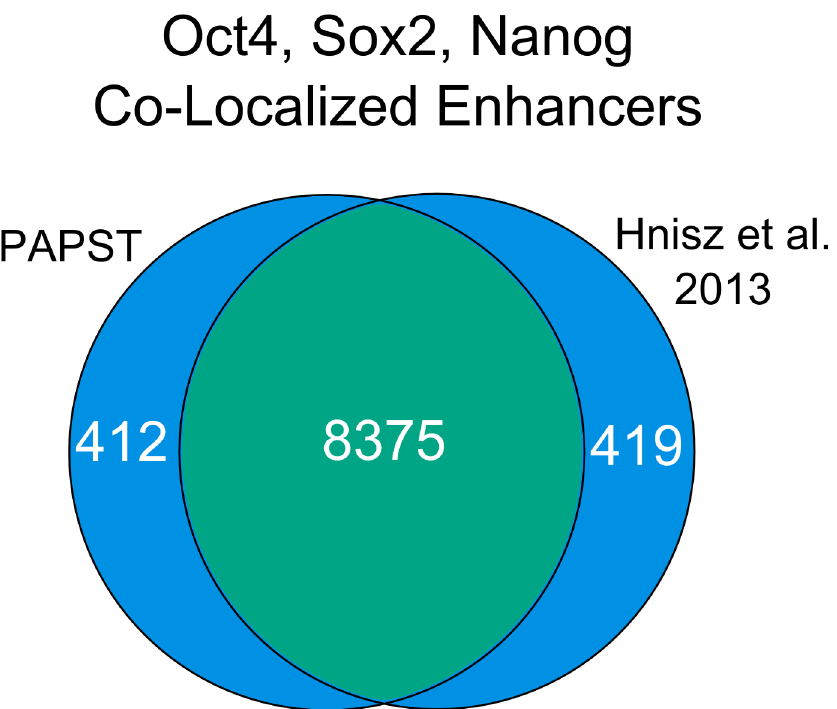
Fig 2. Comparison of PAPST Derived Enhancers to the Literature. Comparison of PAPST identified ESC enhancers with published ESC enhancers [16] shows that PAPST identified over 95% of those found by Hnisz et al. The enhancers were identified through the calculation of genomic regions co-localized by Oct4, Sox2, and Nanog.